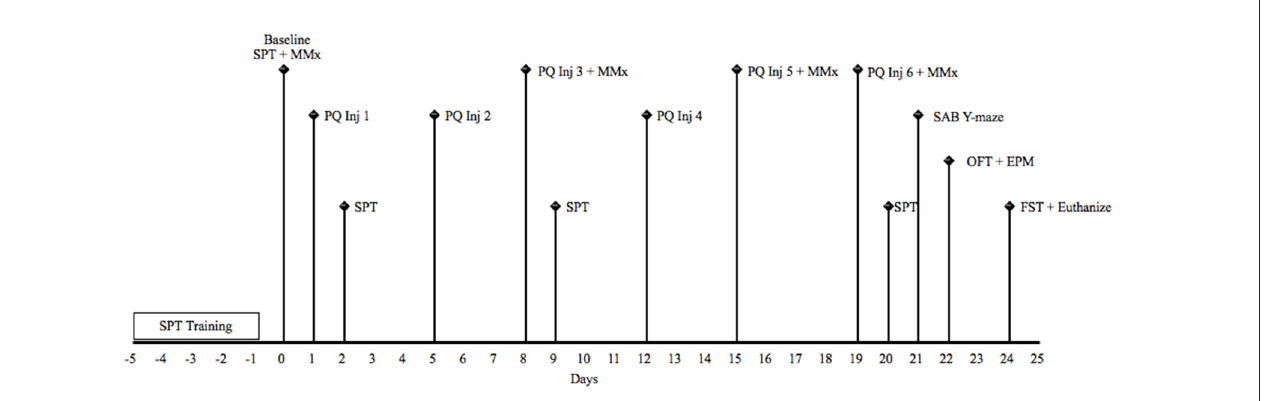
FIGURE 1 | Schematic timeline for study 1. EPM, elevated plus maze; FST, forced Swim test; Inj, injection; MMx, micromax; OFT, open field test; PQ, paraquat (1 or 10 mg/kg); SAB, spontaneous alternation behavior; SPT, sucrose preference